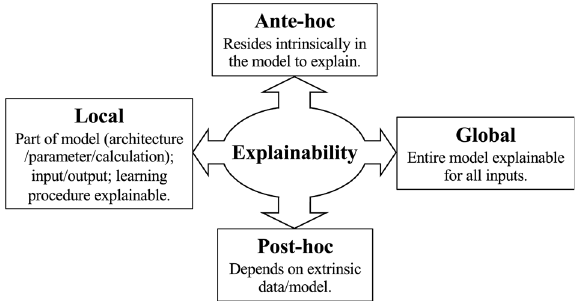
Fig. 1 Different scopes and aspects of explainability. Explainability is not a binary property. In other words, not all explanations address the ante-hoc global explainability of the entire model. Post-doc/ local explanations are also